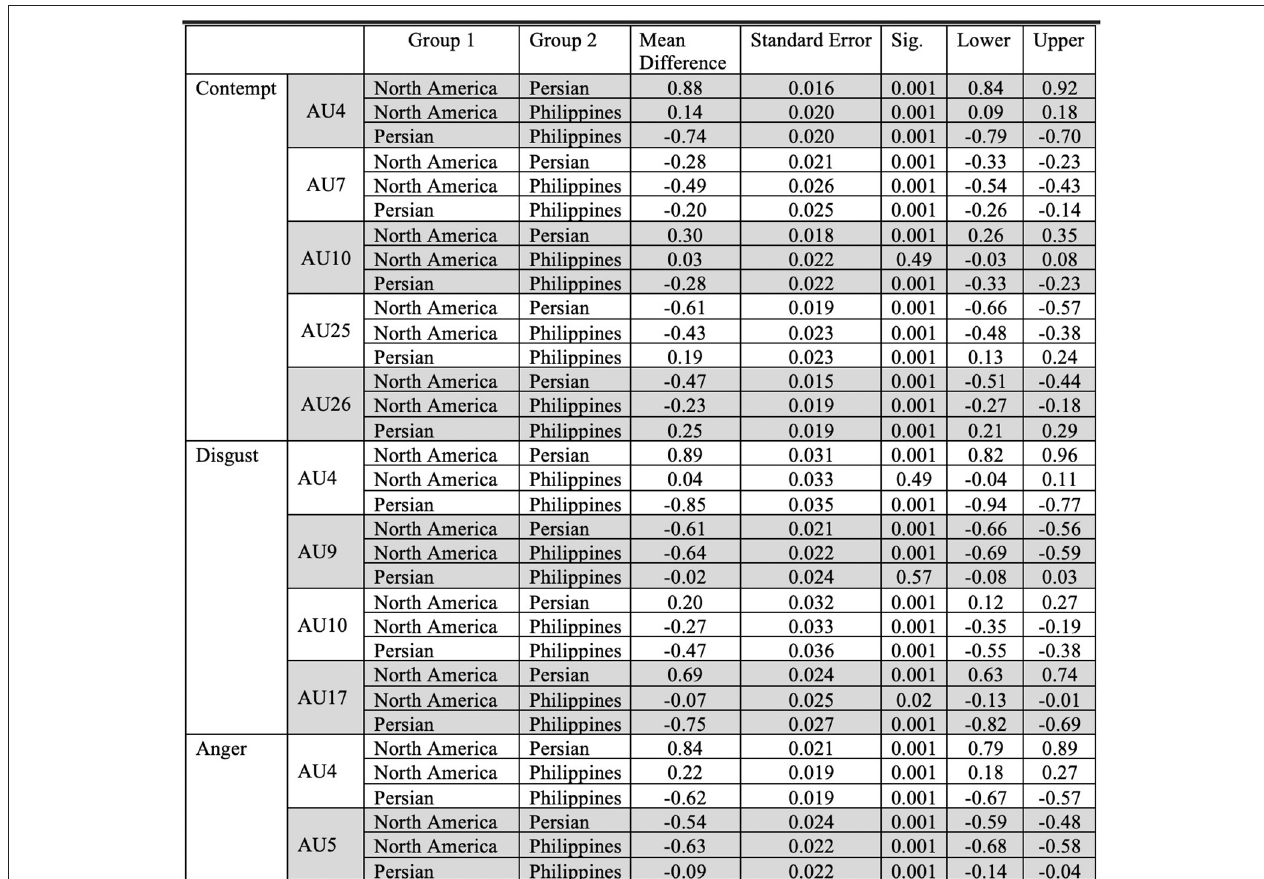
FIGURE 3 | Descriptive statistics for the post-hoc Tukey Test for each emotion across all cultures.